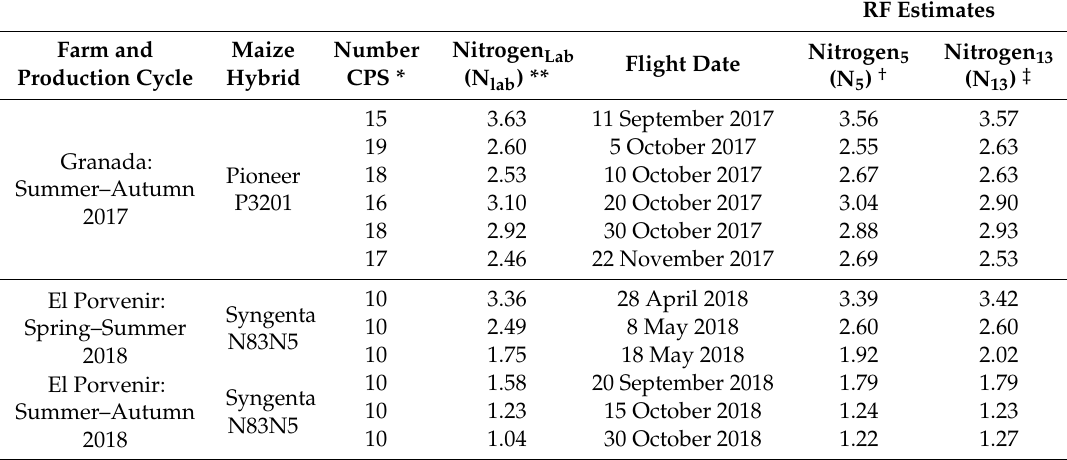
Table 2. Results of total Nitrogen content (Nt) (from field sampling) and estimated Nt using Random Forest (RF) (with five and thirteen indices derived from Unmanned Aerial Vehicles (UAVs)) corresponding to Farm and Production cycle, Maize hybrid, and Flight date.